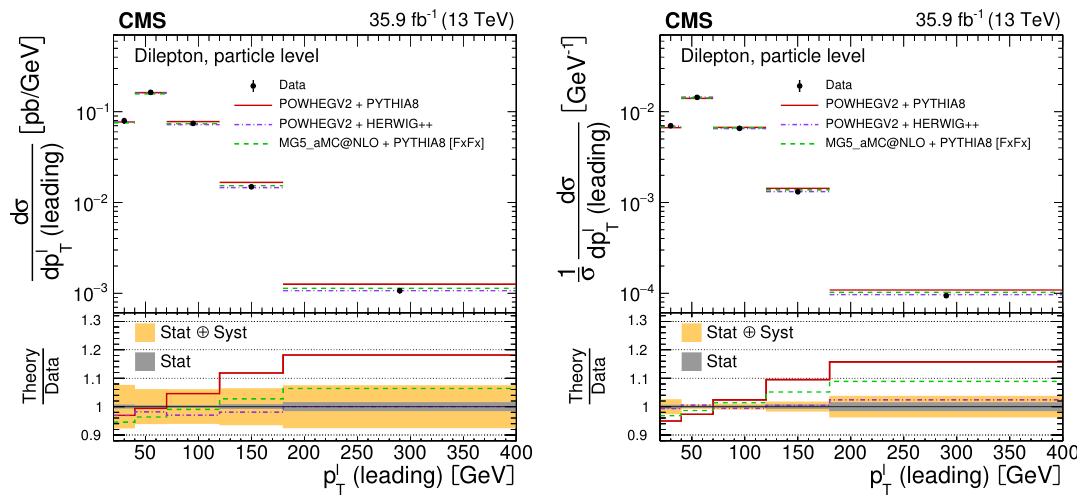
Figure 35 . The di(cid:11)erential tt production cross sections as a function of p ‘ phase space at the particle level are shown for the data (points) and the MC predictions (lines). The vertical lines on the points indicate the total uncertainty in the data. The left and right plots correspond to absolute and normalised measurements, respectively. The lower panel in each plot shows the ratios of the theoretical predictions to the data. The dark and light bands show the relative statistical and total uncertainties in the data, respectively.